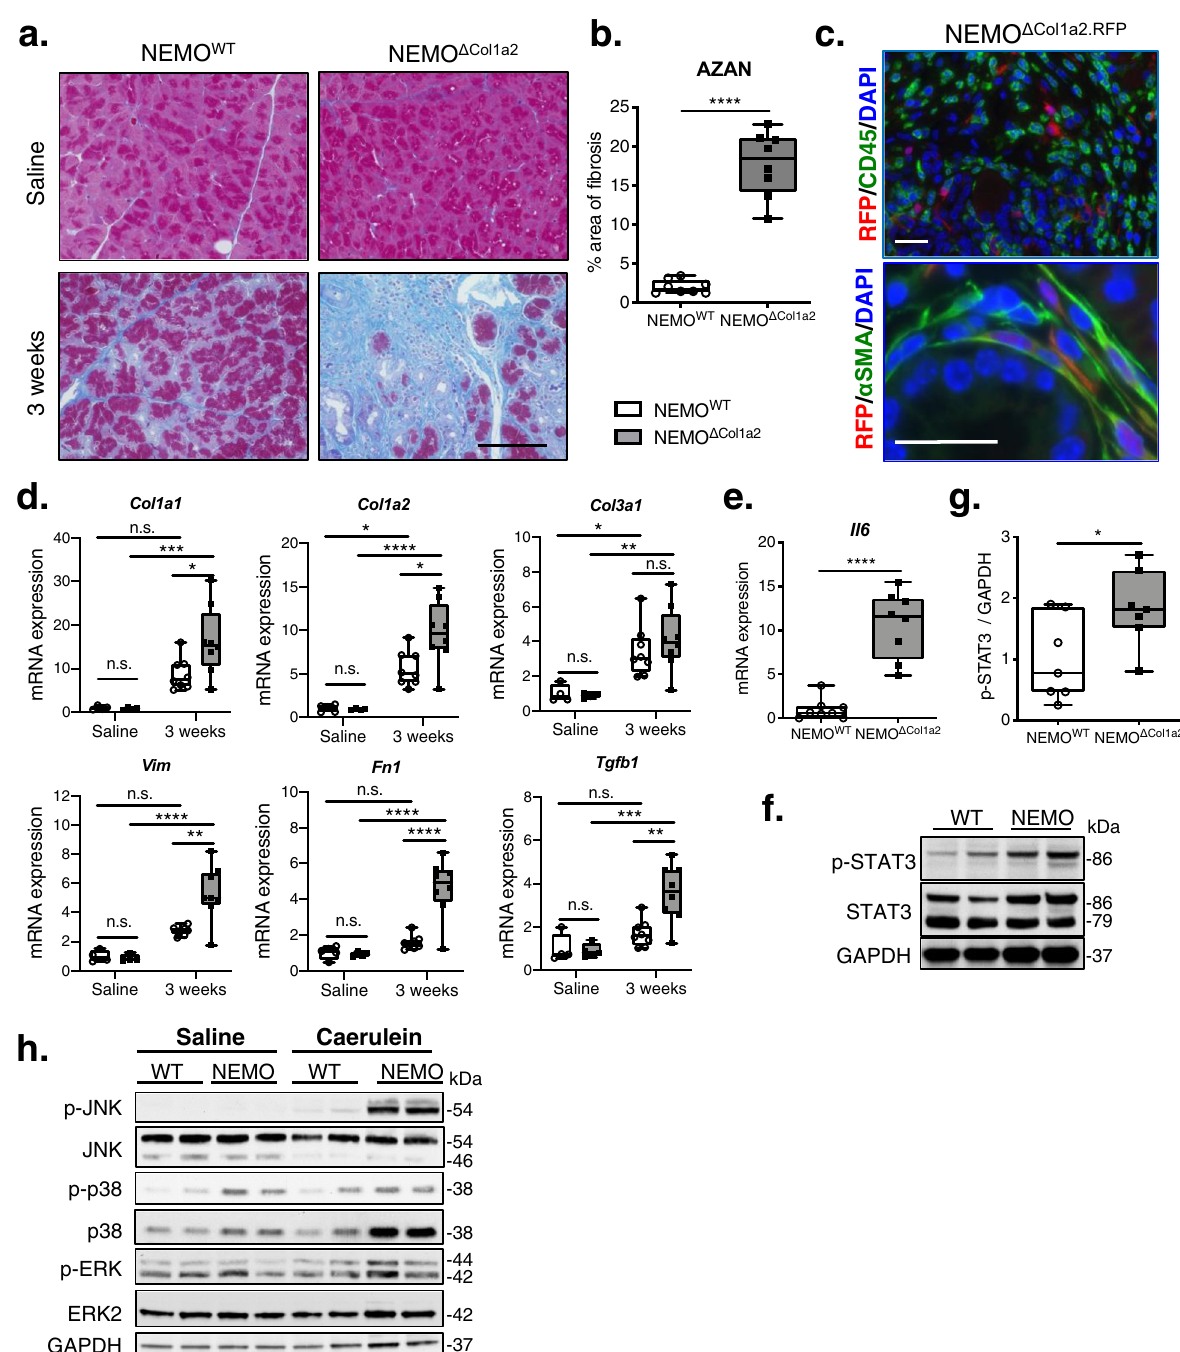
Fig. 5 Ablation of NEMO in PSCs leads to stronger fi brosis after caerulein-induced pancreatitis. a AZAN trichrome staining showing an increase in extracellular matrix deposits (blue). Scale bar: 100 µ m. b Quanti fi cation of AZAN staining as a percentage of area ( n = 8). c Co-staining of RFP/CD45 and RFP/ α SMA on the pancreatic tissue from the NEMO Δ Col1a2.RFP reporter mice. Scale bar: 25 µ m. d Expression of pro- fi brogenic genes analyzed by qPCR (Saline: n = 4; 3 weeks: n = 8). e Expression of Il6 in pancreata analyzed by qPCR ( n = 8). f Immunoblot of p-STAT3 and total STAT3 levels from pancreatic protein extracts. g Ratio of p-STAT3 to GAPDH band intensities ( n = 7). h Immunoblot of components of the MAPK pathway on pancreatic protein extracts. WT: NEMO WT ; NEMO: NEMO Δ Col1a2 . Whiskers: Min to Max. ( b , e , g ) T -test (two-tailed). d One-way ANOVA. * p < 0.05; ** p < 0.01; *** p < 0.001; **** p < 0.0001. All n numbers represent biological